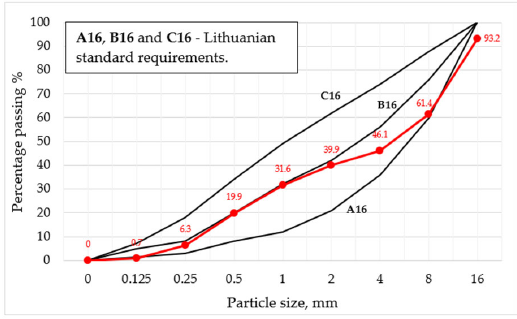
Figure 1. Granulometric curve of concrete aggregates mix.